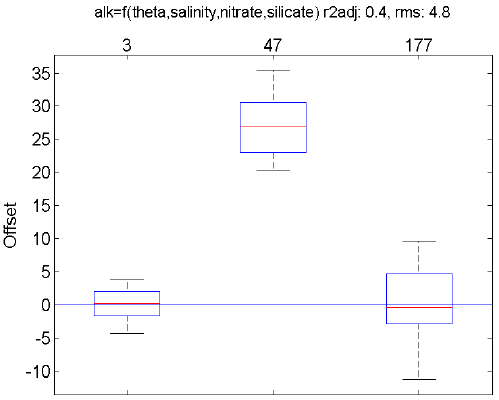
Figure 6. MLR results for TA in the Makarov Basin (o ff sets in µ molkg − 1 ).